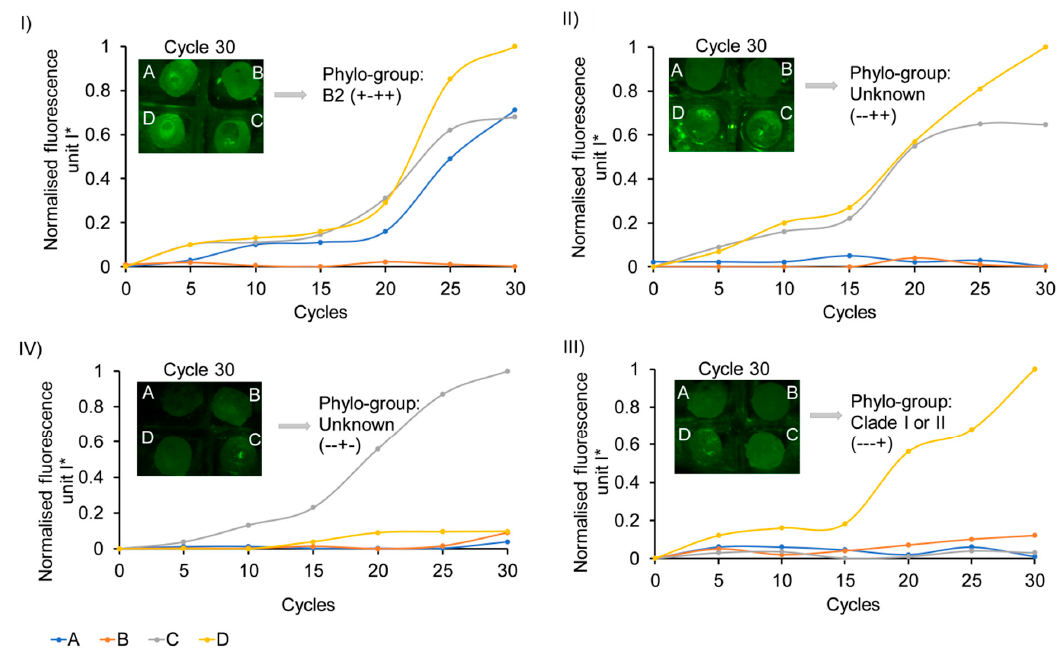
Figure 3. Amplification plot and phylogrouping of E. coli strains using core shell beads. ( I ) Positive control; ( II – IV ) unknown samples; A, B, C, and D beads containing specific set of primers to detect chuA, arpA, TspE4C2, yjaA genes individually; and images of core shell beads, are provided as insets.